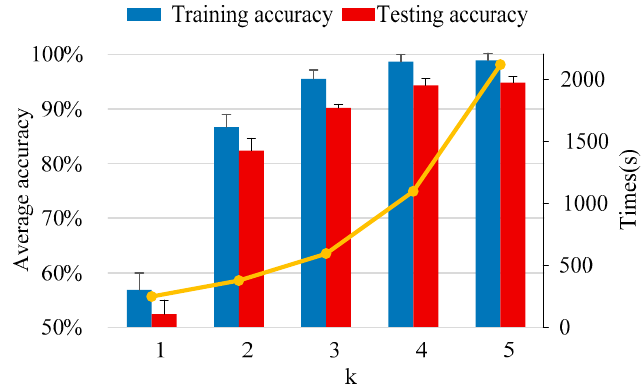
ff erent k . Appl. Sci. 2020 , 10 , x FOR PEER REVIEW